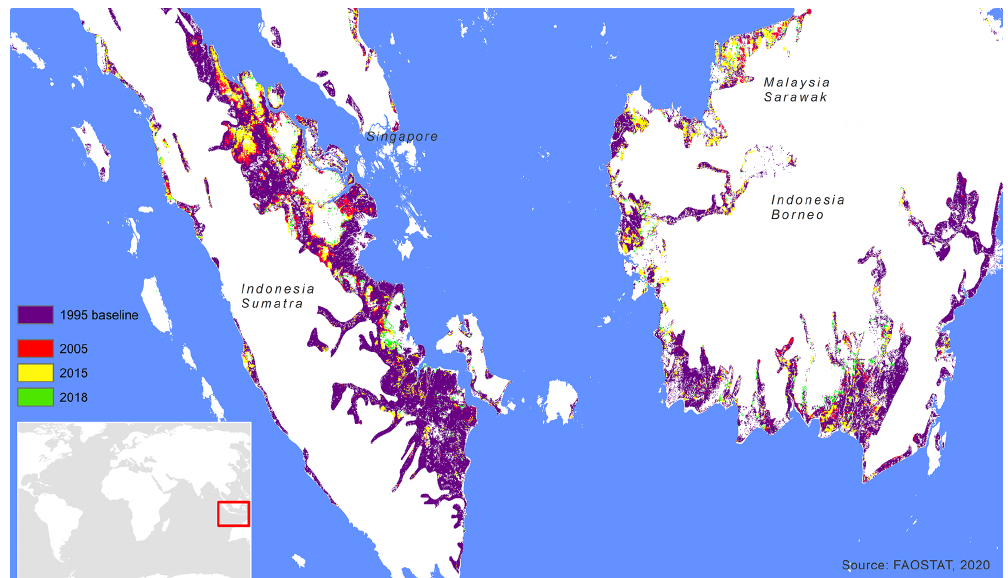
Figure 12. FAOSTAT estimates of the extent of drained organic soils in Indonesia and Malaysia over time, showing total drained area in 1995 and successive additions by 2005, 2015 and